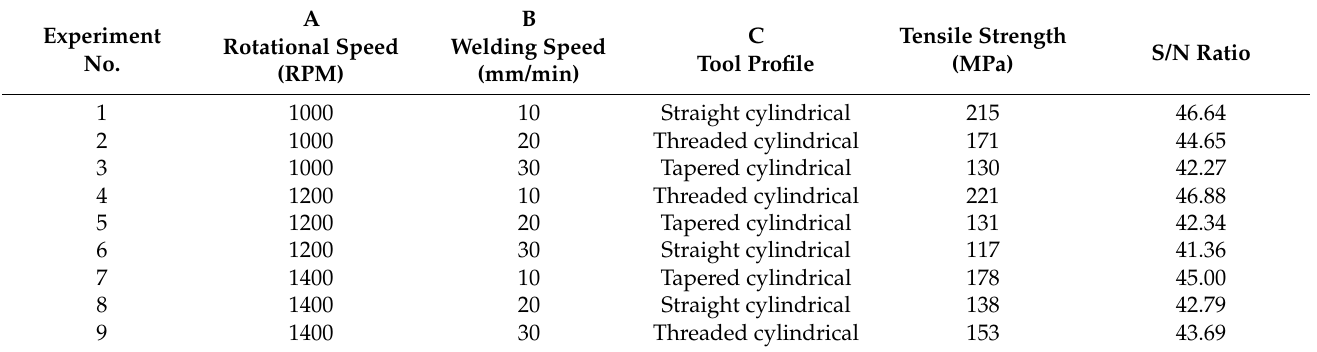
Table 2. Experimental layout: L9 orthogonal array, mean tensile strength values, and S/N ratio values.